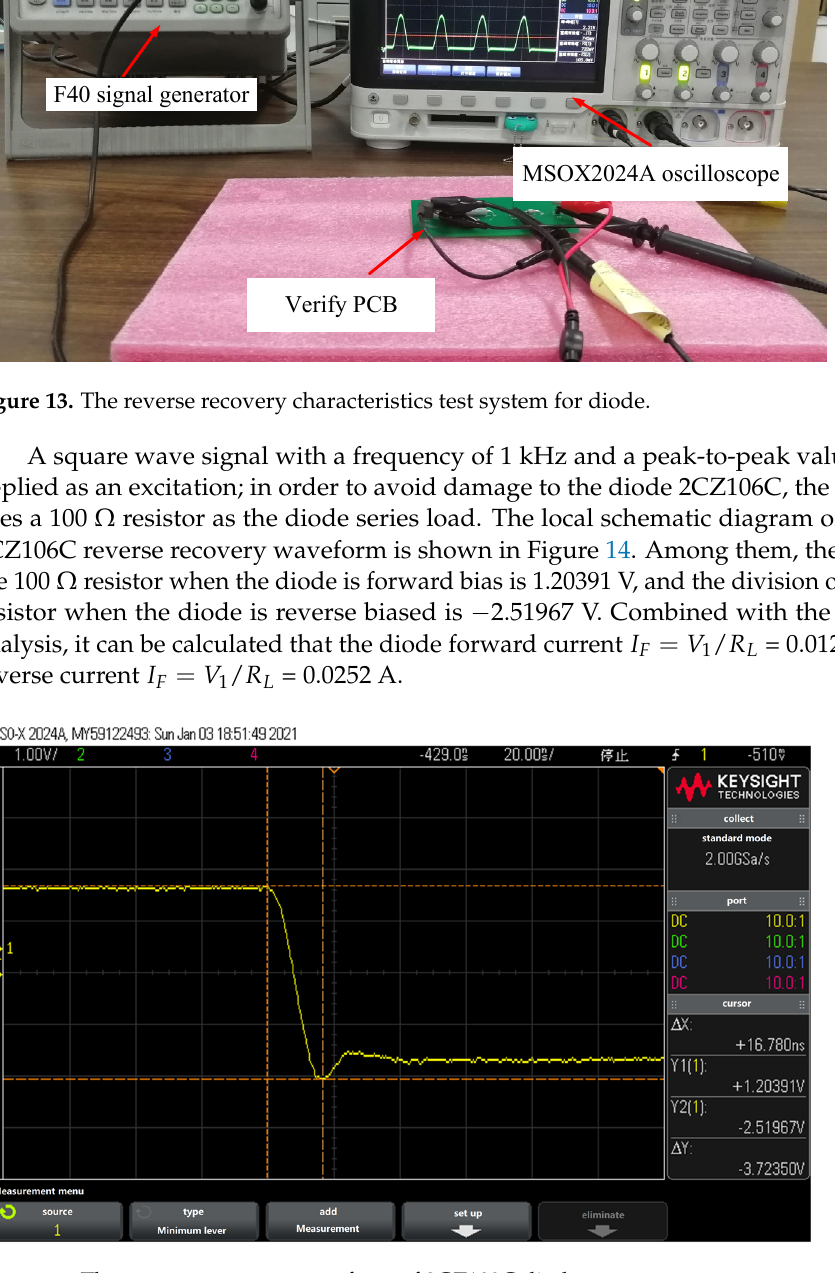
14 of 24 Figure 12. Comparison of fitting and measured curves of junction capacitance characteristics. In diode EMC models, reverse recovery characteristics are generally characterized by time-of-flight 𝑇𝑇 . The reverse recovery time 𝑡 (cid:3045) of diode 2CZ106C can be obtained by building an external circuit test, and the model parameter 𝑇𝑇 can be further obtained. For the experimental test of diode reverse recovery time 𝑡 (cid:3045) , the square wave with a given duty cycle of 50% can be used as the excitation signal by the F40-type digital synthesis